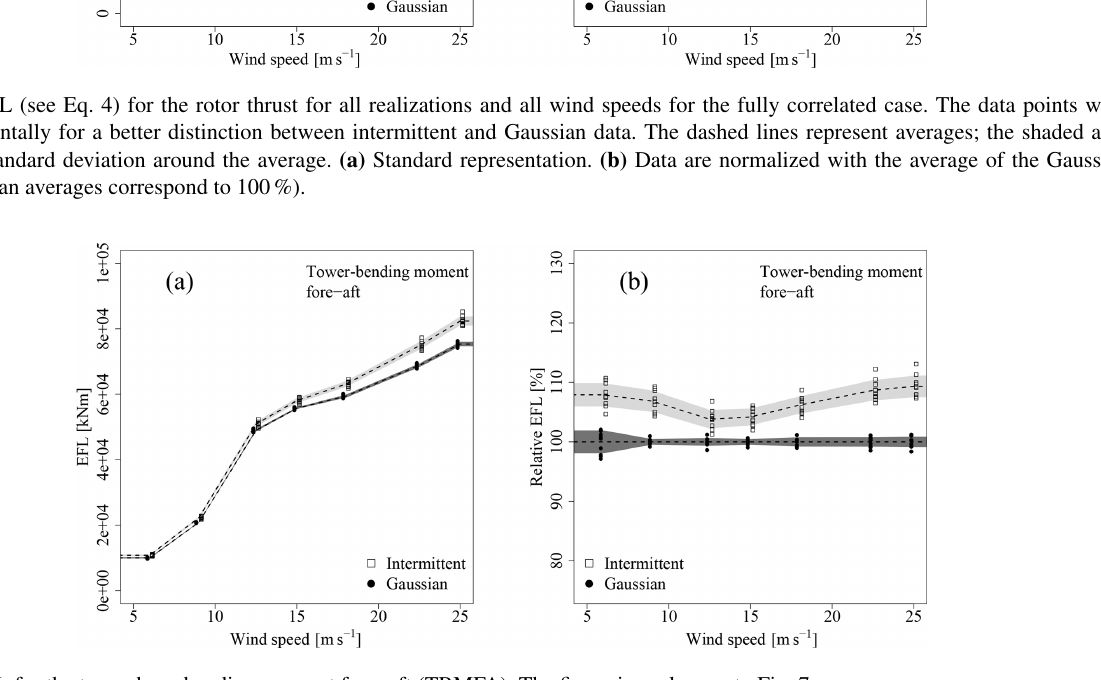
Figure 8. EFL for the tower-base-bending moment fore–aft (TBMFA). The figure is analogous to Fig.